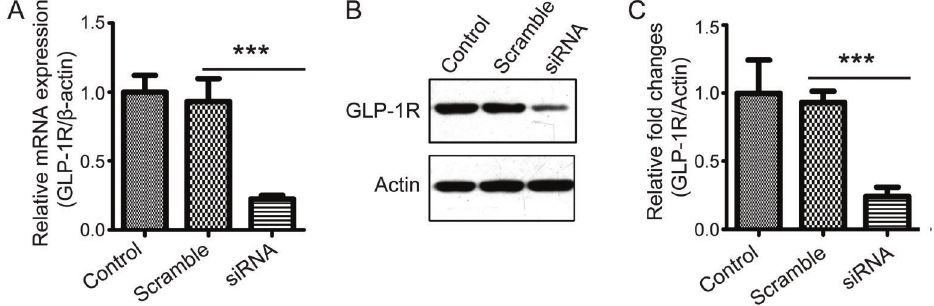
Figure 1. GLP-1R knockdown in macrophages using siRNA. RAW264 cells were transfected with siRNA of GLP-1 receptor (GLP-1R) and scramble siRNA for 72 h. A , The mRNA levels of GLP-1R normalized to b -actin were assessed by qPCR. Data are reported as relative values compared to the control group (n=6). B , Protein levels of GLP-1R assessed by western blot. C , Relative fold changes by western blot. The results are representative of three independent experiments. Data are reported as means ± SD. ***P o 0.001